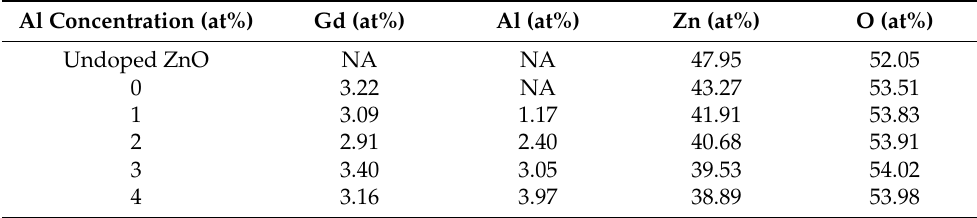
Table 3. The composition of (Gd, Al) co-doped ZnO films at various Al concentrations. Al Concentration (at%)